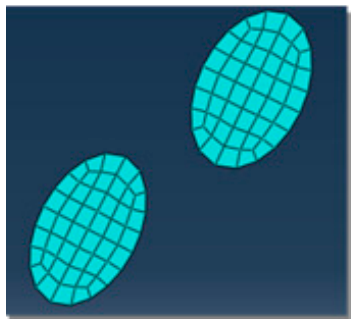
Figure 6. Particle meshing.